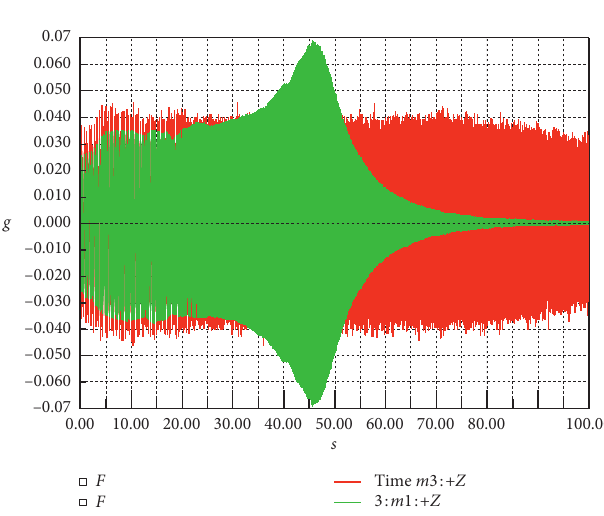
Figure 17: Z -direction acceleration curve.